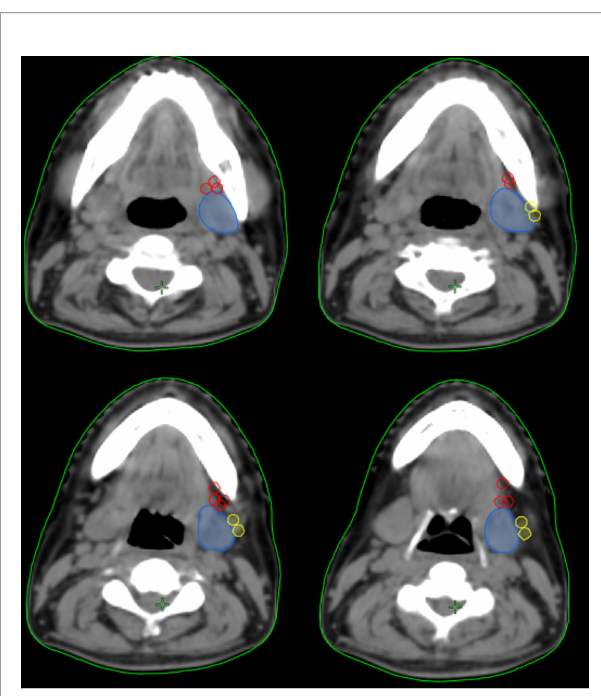
FIGURE 3 | The patterns of peri-submandibular lymph node metastases in axial (A) , three-dimensional (B) , coronal (C) , and sagittal views (D) (blue, submandibular gland; red, lymph node metastases in the anterior part of the submandibular gland; yellow, lymph node metastases in the lateral part of the submandibular